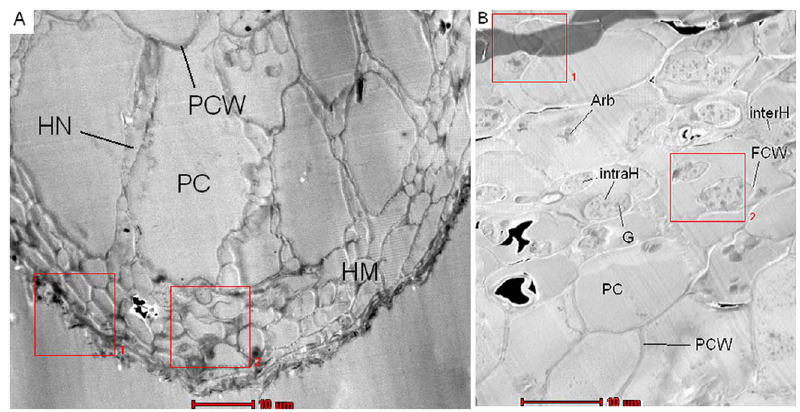
Fig. 1. Cross section of beech (A, Fagus sylvatica ) and ash (B, Fraxinus excelsior ) mycorrhizal root tips. The beech root was colonized by Lactarius subdulcis and the ash root by Glomus sp. PCW 5 plant cell wall, HN 5 Hartig Net, PC 5 plant cell, FCW 5 fungal cell wall, HM 5 hyphal mantle, Arb 5 arbuscles, intraH 5 intracellular hyphae, interH 5 intercellular hyphae. Bar 5 10 m m. Area 2 (red square) 5 area for EDX- STEM mapping with 40 6 40 measurement points. Area 1 was used for drift correction.